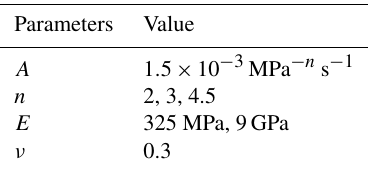
Table 1. Mechanical parameters used in the elasto-viscoplastic modeling of ice implemented in